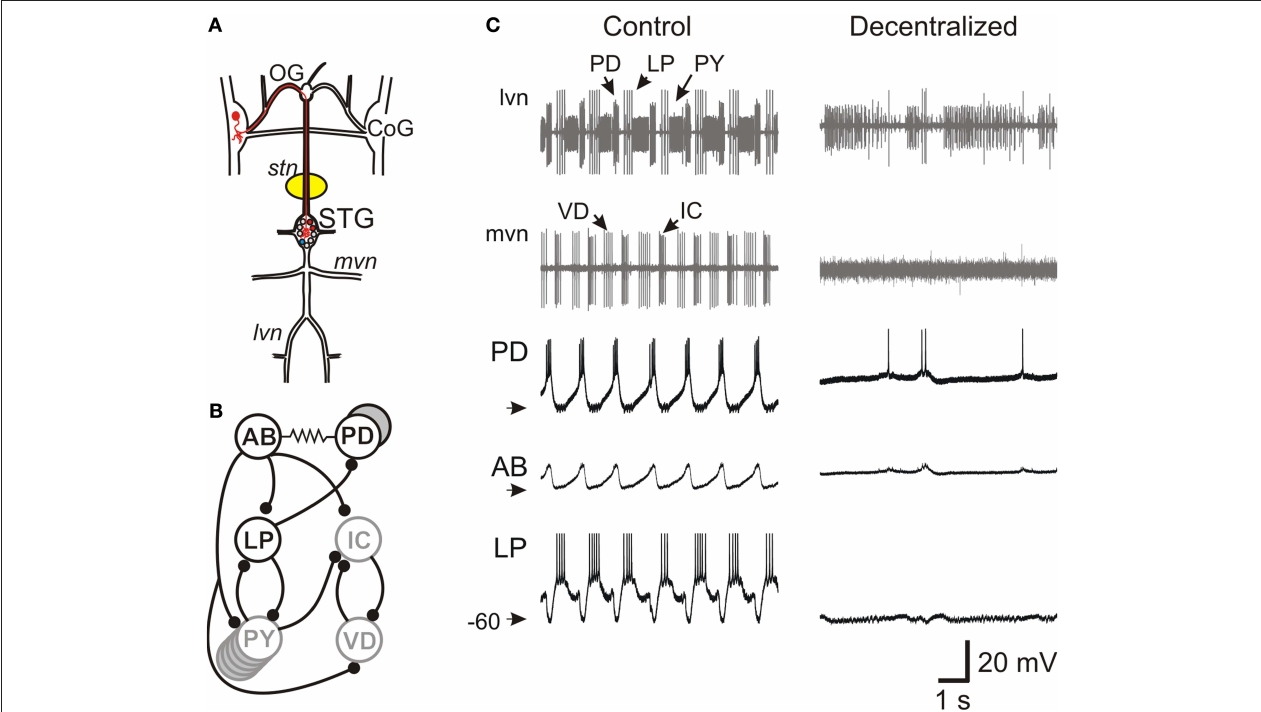
Figure  | effect of decentralization on the pyloric network oscillations. (A) Schematic diagram of the stomatogastric nervous system. The medial and lateral ventral motor nerves (mvn, lvn) contain axons from motor neurons located in the stomatogastric ganglion (STG). The STG receives descending projections from neurons with somata located in the oesophageal ganglion (OG) and the paired commissural ganglion (CoG, one such projection neuron is labeled in red). A petroleum jelly well (yellow) around the desheathed stomatogastric nerve (stn) is filled with 0.75-M sucrose plus 1-μM TTX to block action potential transmission of descending projections to the STG (decentralization). (B) Schematic diagram of main synaptic connections among pyloric network neurons. All chemical